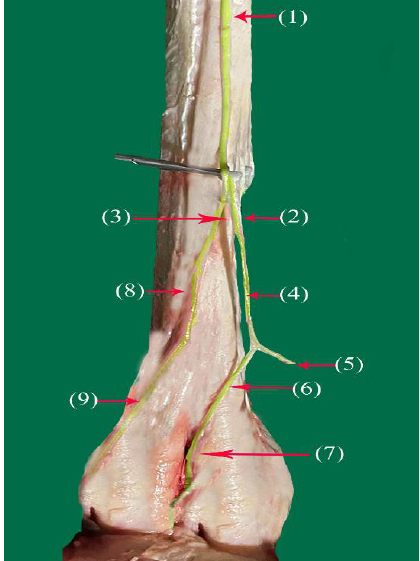
Figure 4. Nerve supply of the plantar surface of the distal hindlimb in camels: (1) tibial nerve; (2) medial plantar nerve of the III digit; (3) lateral plantar nerve of the IV digit; (4) common plantar digital nerve of the III digit (continuation of medial plantar nerve); (5) abaxial plantar proper digital III nerve; (6) interdigital branch of lateral plantar nerve; (7) axial plantar proper digital III nerve; (8) common plantar digital nerve of the IV digit (continuation of lateral plantar nerve); (9) abaxial plantar proper digital IV nerve.